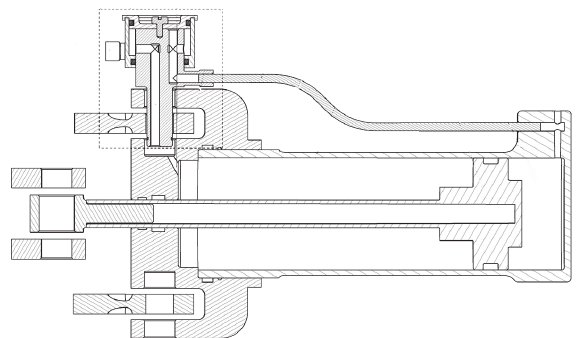
Figure 2: Assembly parts profile of the swivel reversal valve and